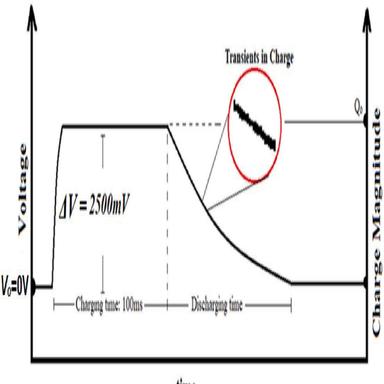
Time based voltage-charge (V–Q) diagram for Q-DLTS.